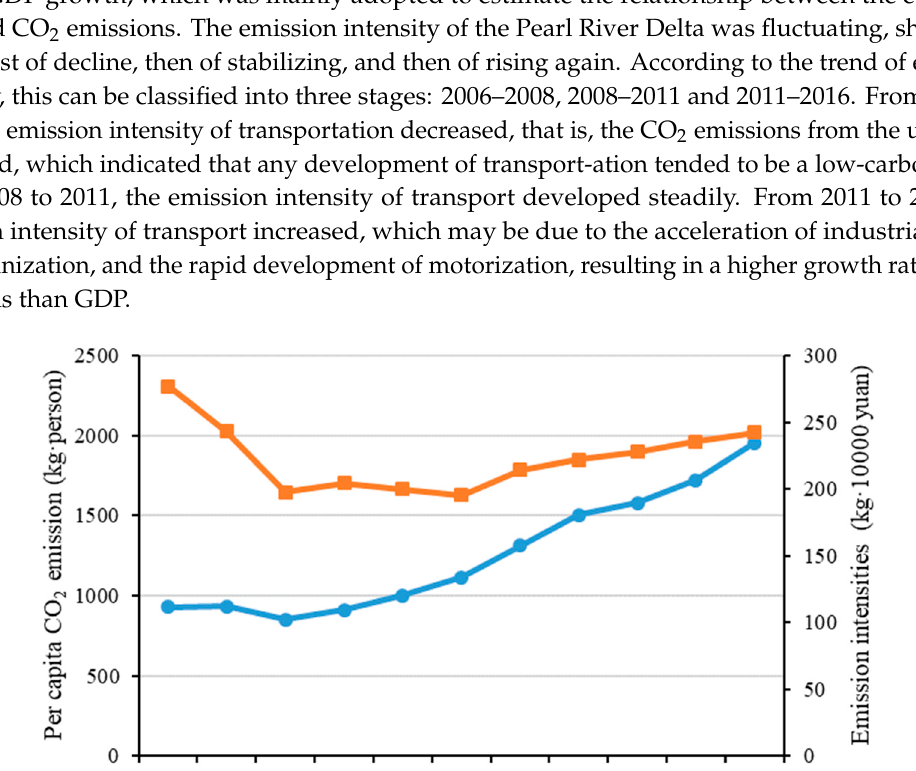
Figure 7. The CO 2 emissions of various vehicles of the Pearl River Delta, 2006 – 2016.